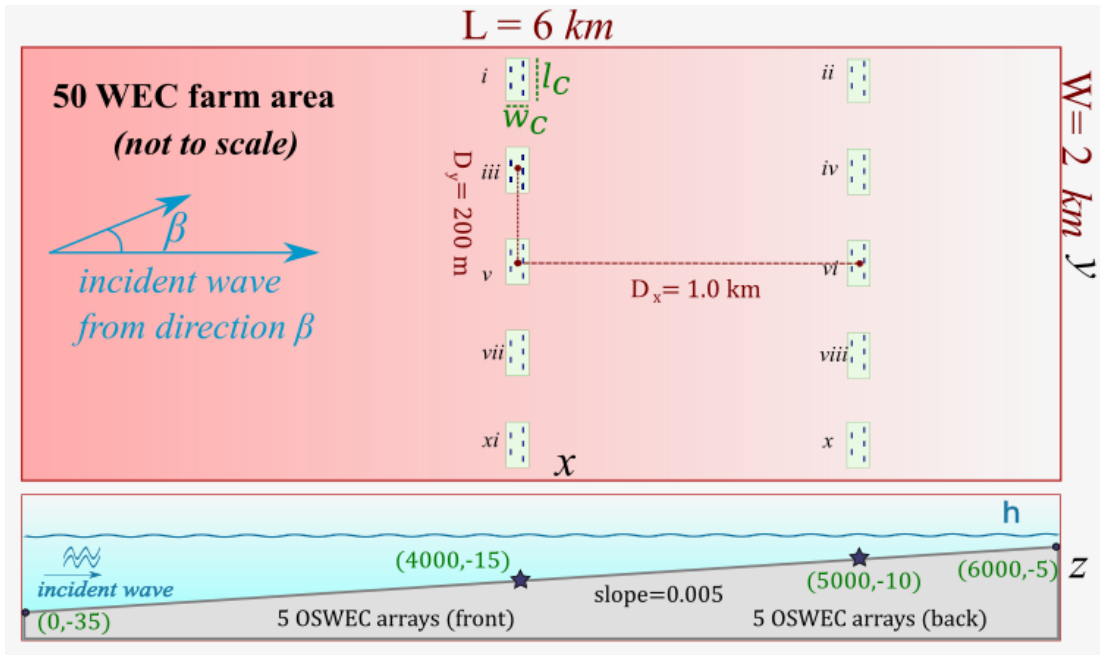
Figure 4. 50 WEC farm schematic shown to scale; top and side views.